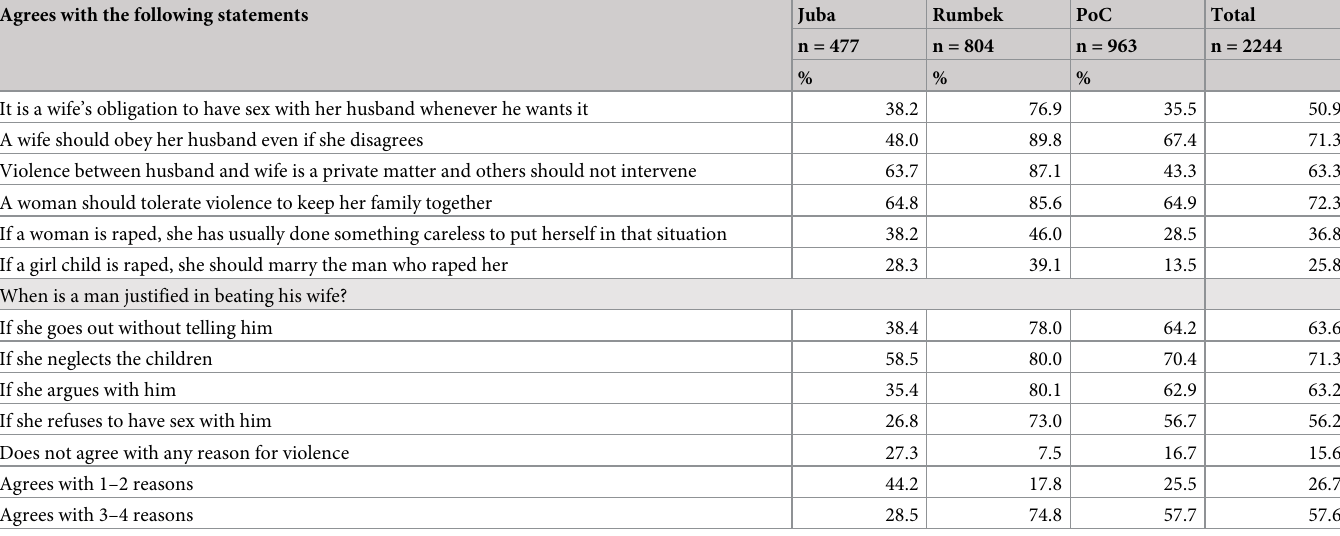
Table 6. Endorsement of restrictive gender norms a